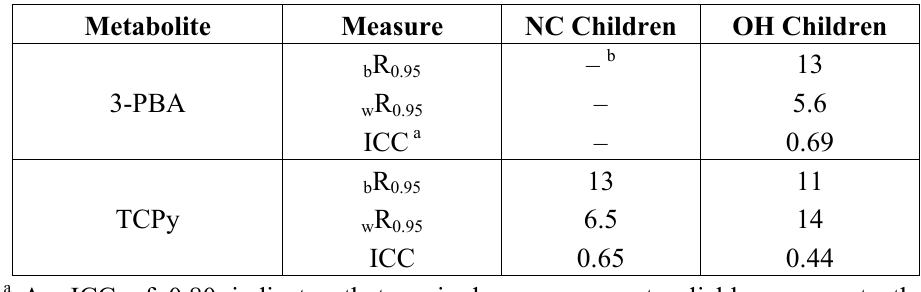
Table 4. Estimated between- and within-person fold-ranges ( Intraclass Correlation Coefficients (ICC) for logged urinary pesticide metabolite concentrations from children in the CTEPP